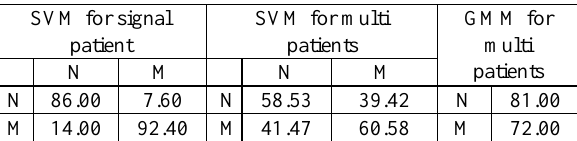
Figure 3. SVM/GMM processing. Table 1. Result of Classification (N: Normal M: Manic)